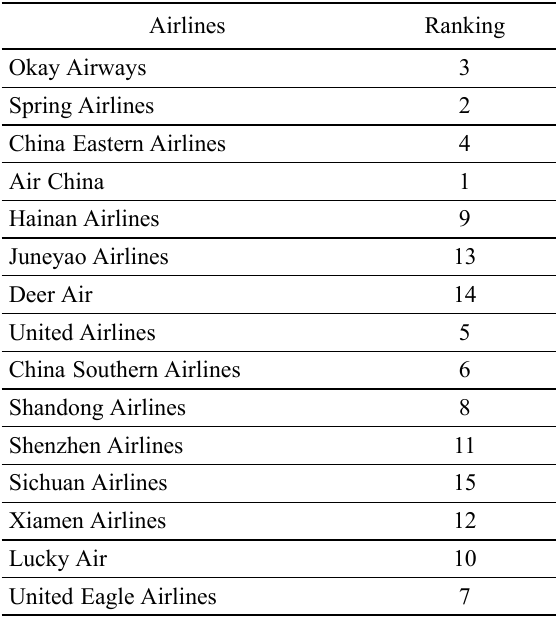
Table 18. Evaluation results and rankings based on